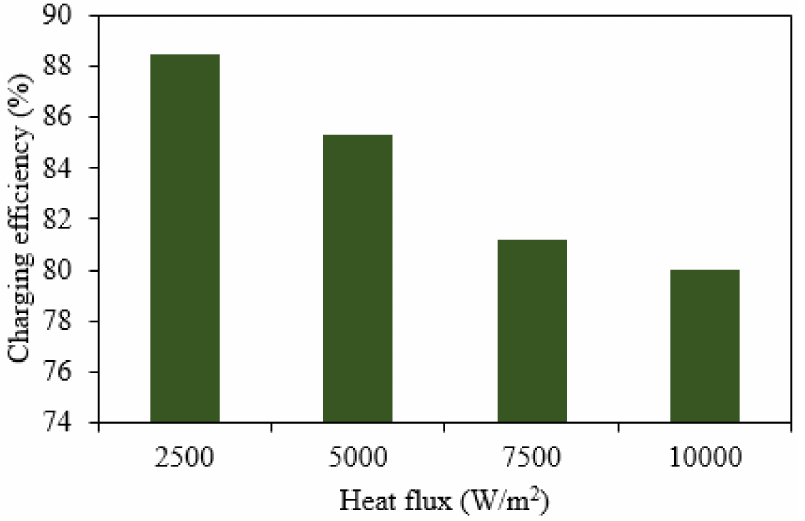
Figure 10. Effect of heat flux on charging efficiency.